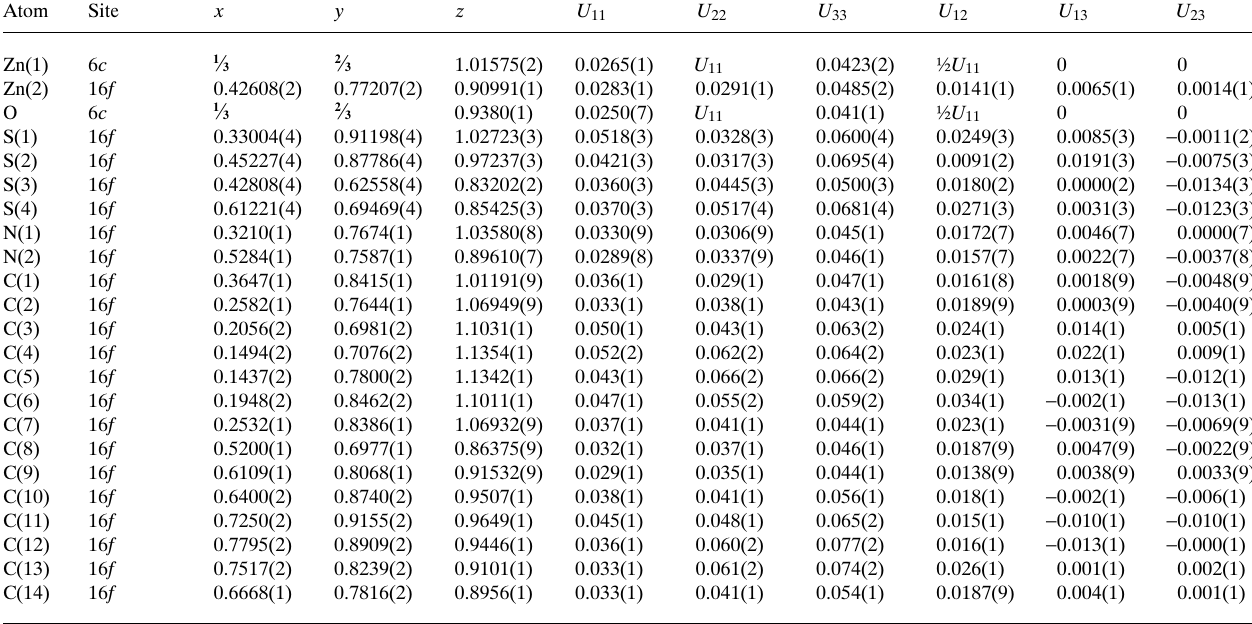
Table 3. Atomic coordinates and displacement parameters (in Å 2 ) .